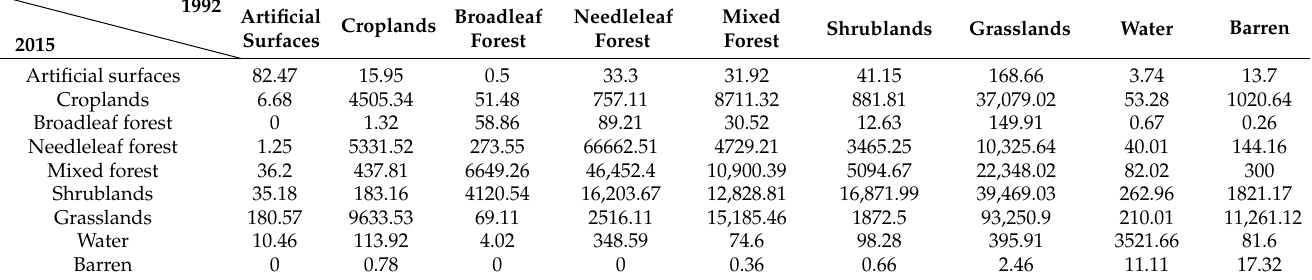
Table 5. Land Use Transfer Matrix of Selenga River Basin from 1992 to 2015. Unit: km 2